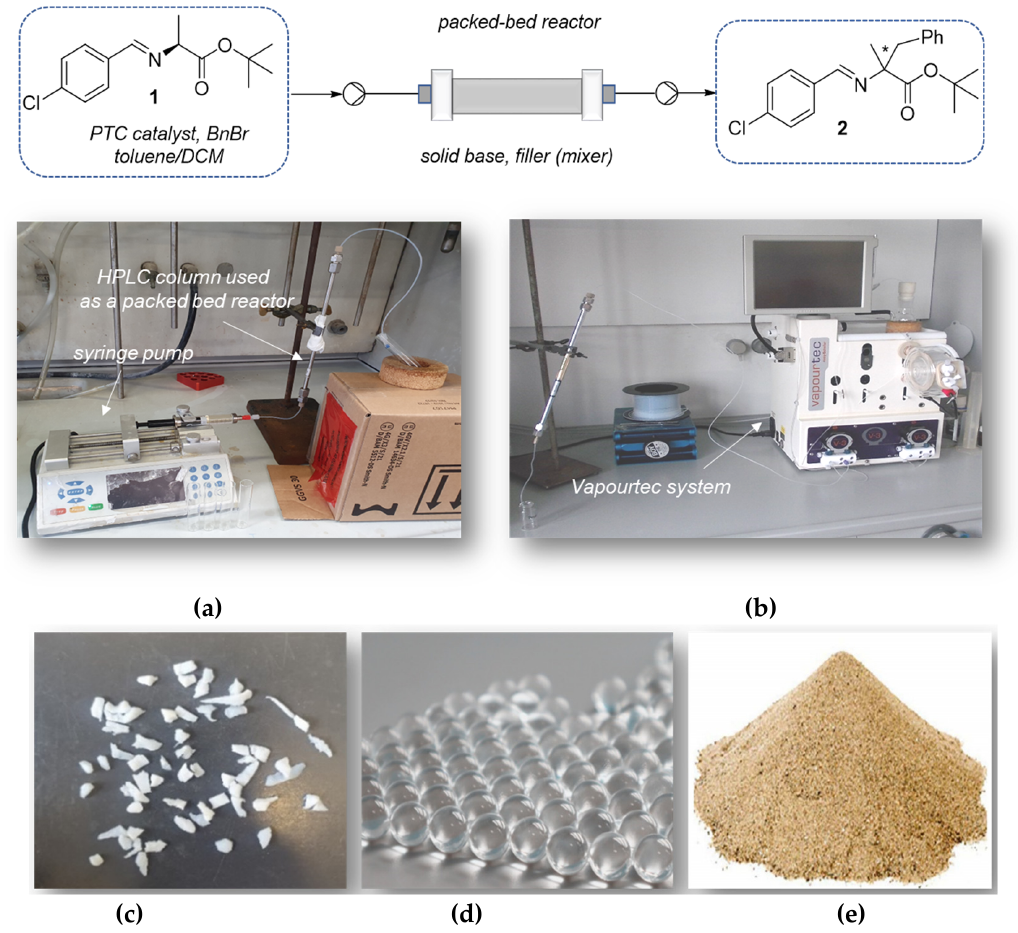
Figure 3. Solid-liquid phase transfer benzylation in packed—bed reactor, ( a ) reaction mixture dosing by syringe pump, ( b ) reaction mixture dosing by Vapourtec pump, ( c ) PTFE boiling stones, ( d ) glass beads or ( e ) sand as inert material .